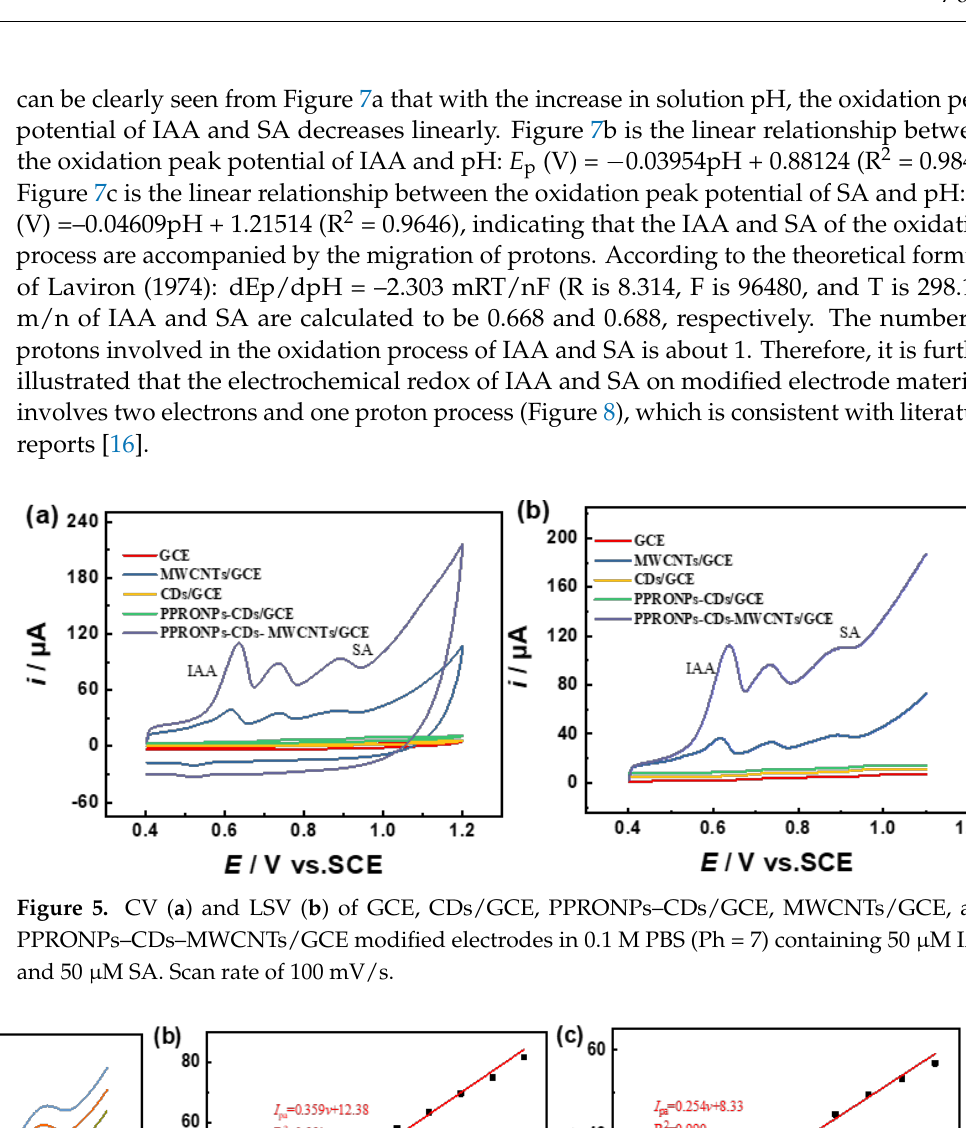
Figure 5. CV ( a ) and LSV ( b ) of GCE, CDs/GCE, PPRONPs − CDs/GCE, MWCNTs/GCE, and PPRONPs − CDs − MWCNTs/GCE modified electrodes in 0.1 M PBS (Ph = 7) containing 50 μM IAA and 50 μM SA. Scan rate of 100 mV/s.